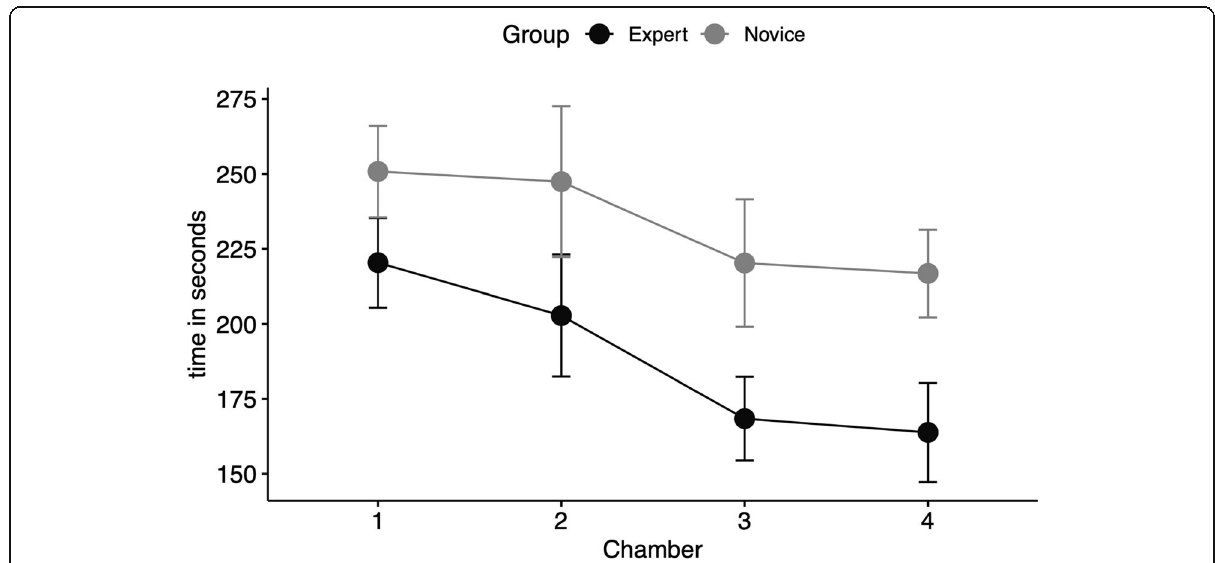
Fig. 6 Comparison of procedure times in seconds (mean ± SE (standard error)) between experts and